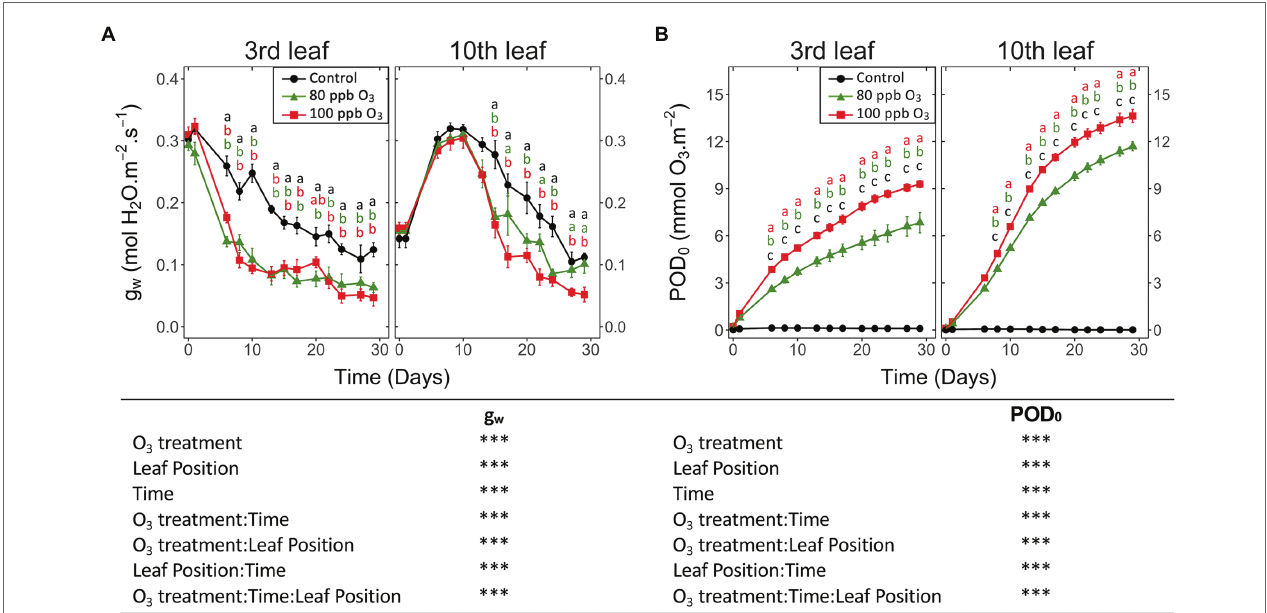
FIGURE 1 | Dynamics of changes in the (A) stomatal conductance to water (g w ) and (B) phytotoxic O 3 dose (POD 0 ) of hybrid poplar leaves ( Populus tremula x alba ), as a function of O 3 treatment (charcoal-filtered air ● , 80 ppb O 3 ▲ , 100 ppb O 3 ◼ ), leaf position, time of assessment and interactions {model: lmer[sqrt(variable)] ~ O 3 treatment ∗ leaf position ∗ time + (1 | tree / chamber); ∗∗∗ p ≤ 0.001}. Values represent means ± SE, n = 6. Different letters indicate significant differences between treatments for a given assessment date ( post-hoc Tukey’s Honest significant difference, p ≤